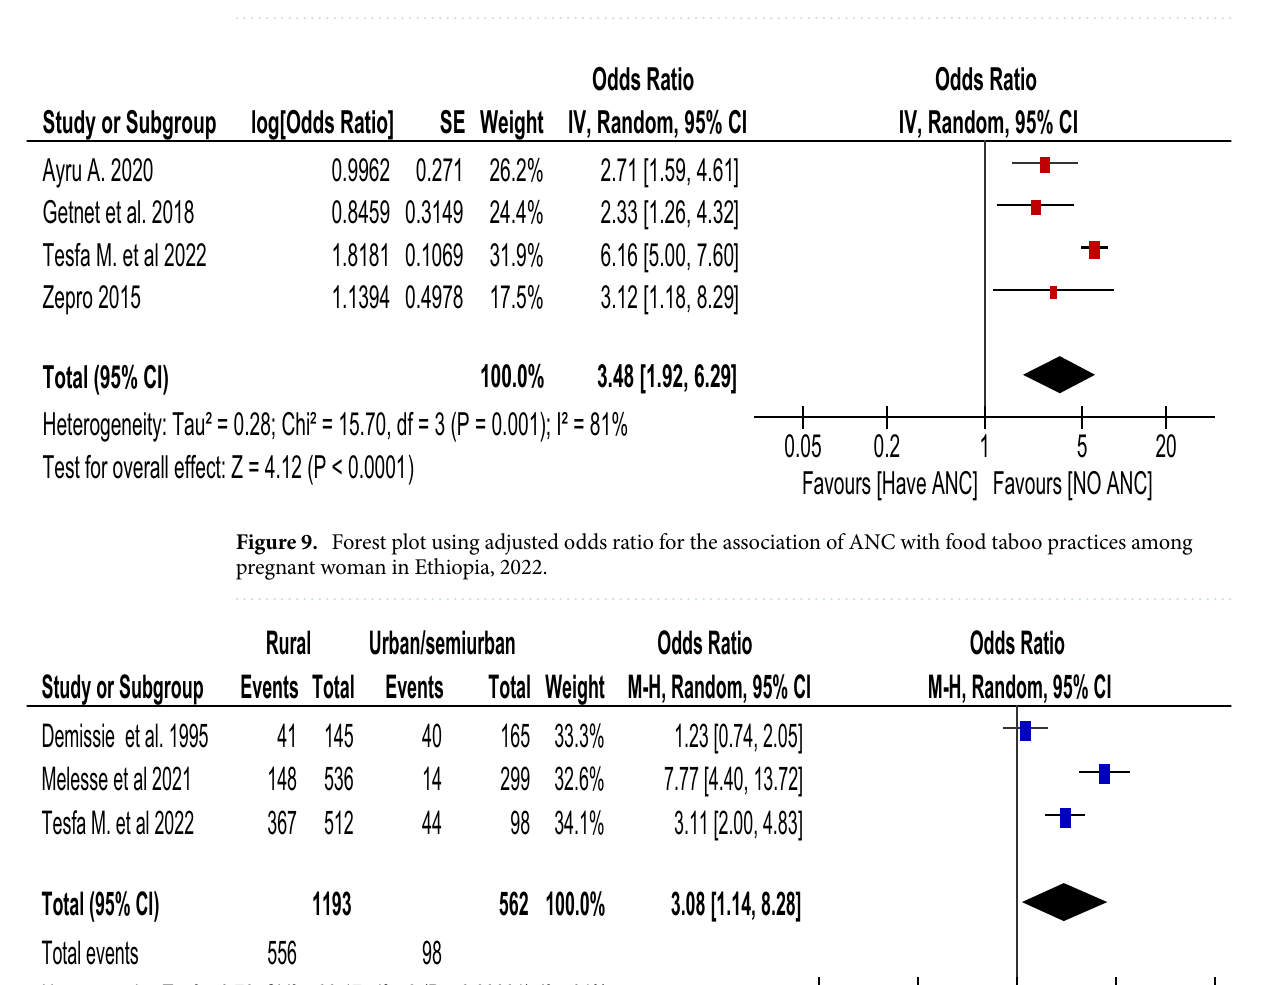
Figure 8. An unadjusted odds ratio forest plot for the Association of ANC with food taboo practices among pregnant women in Ethiopia, 2022.